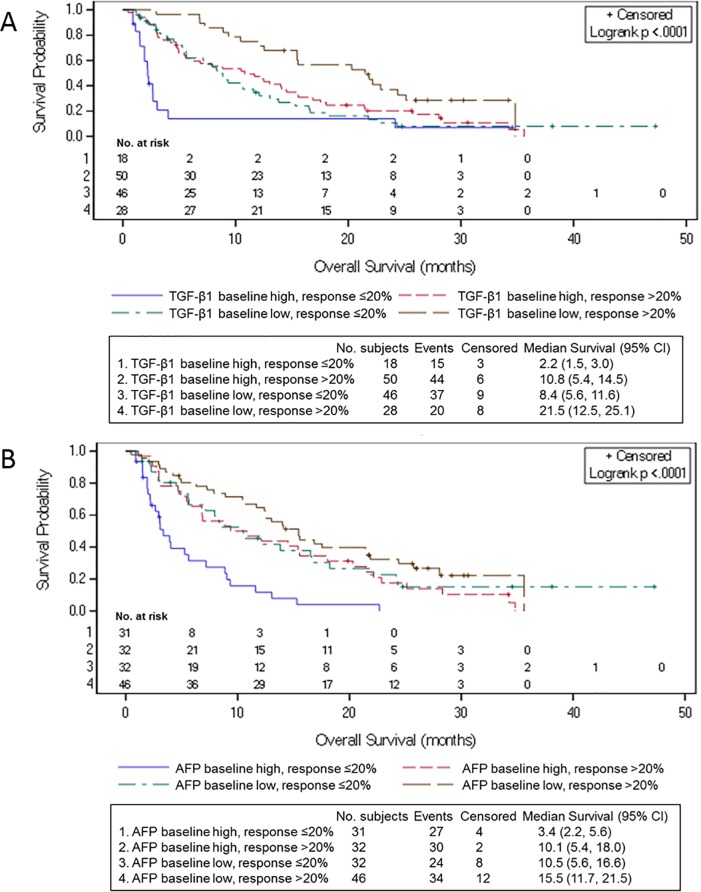
OS by the combination of baseline AFP and TGF-β1, and TGF-β1 response (Parts A and B patients). (A) Baseline TGF-β1 and TGF-β1 response. (B) Baseline AFP and TGF- β1 response.